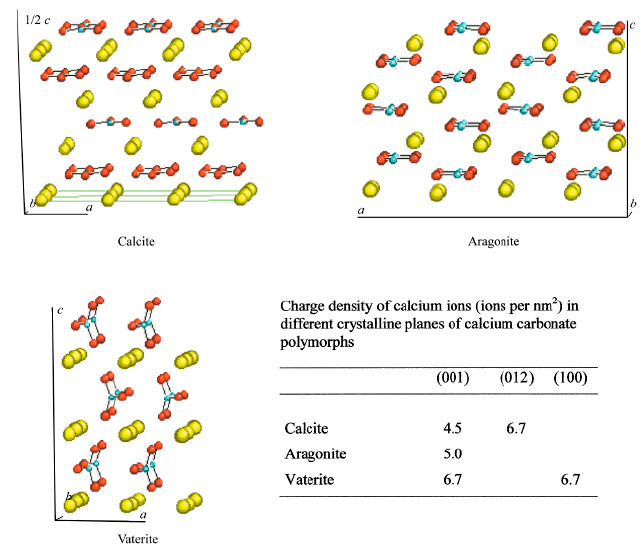
Figure 6. Calcium carbonate polymorphs organization and charge [12]. With permit of the copyright (Copyright Clearance Center License 4635640148155).